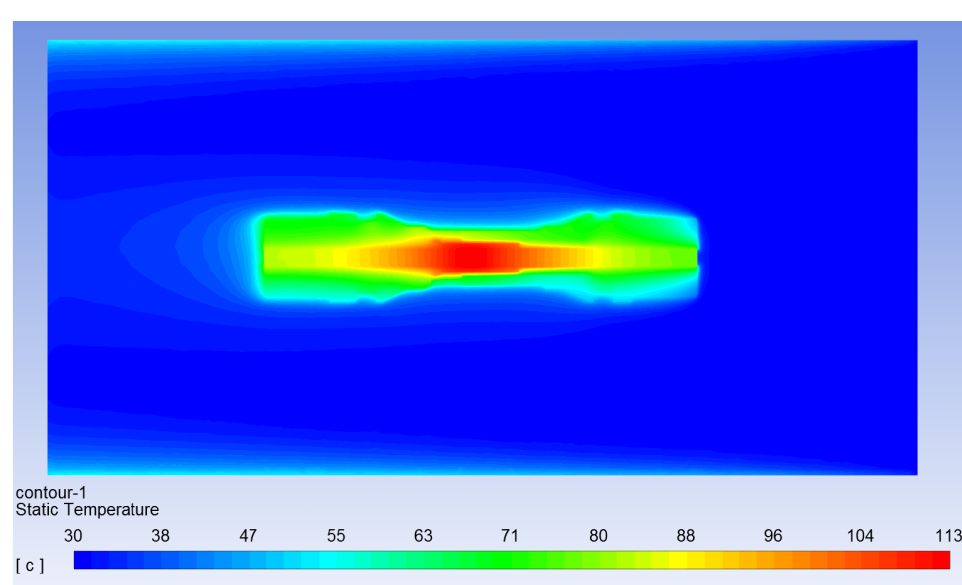
Figure 10. Temperature distribution around DC connector with current flow ( I = 11.4 A) — case 7 in Table 1. Max temperature: 110 °C.